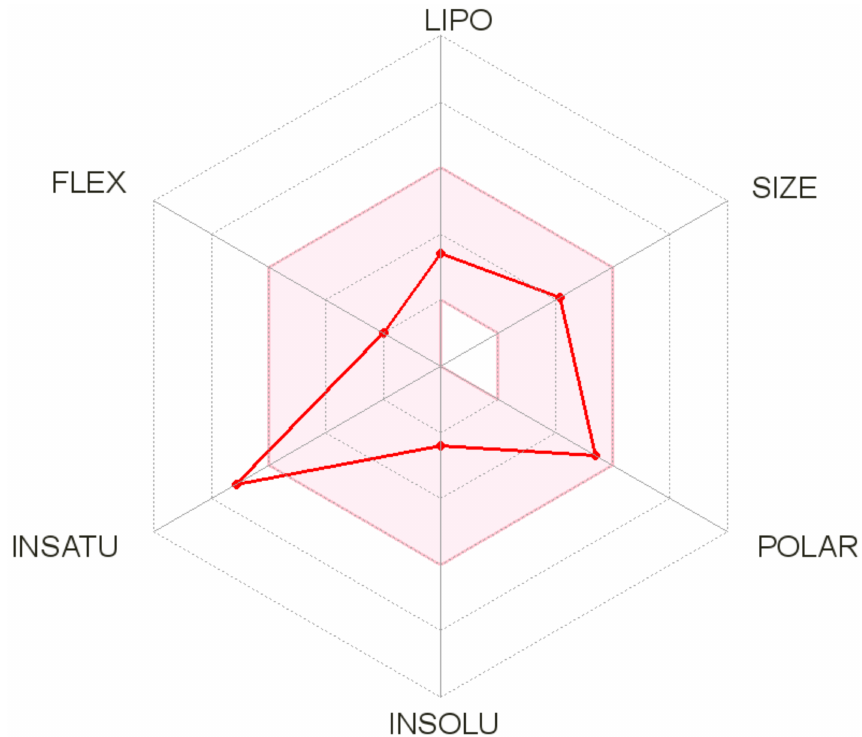
Figure 7. The Bioavailability Radar shows that compound 12 , represented by central red lines fits in the pink area which is the optimal range for each property.